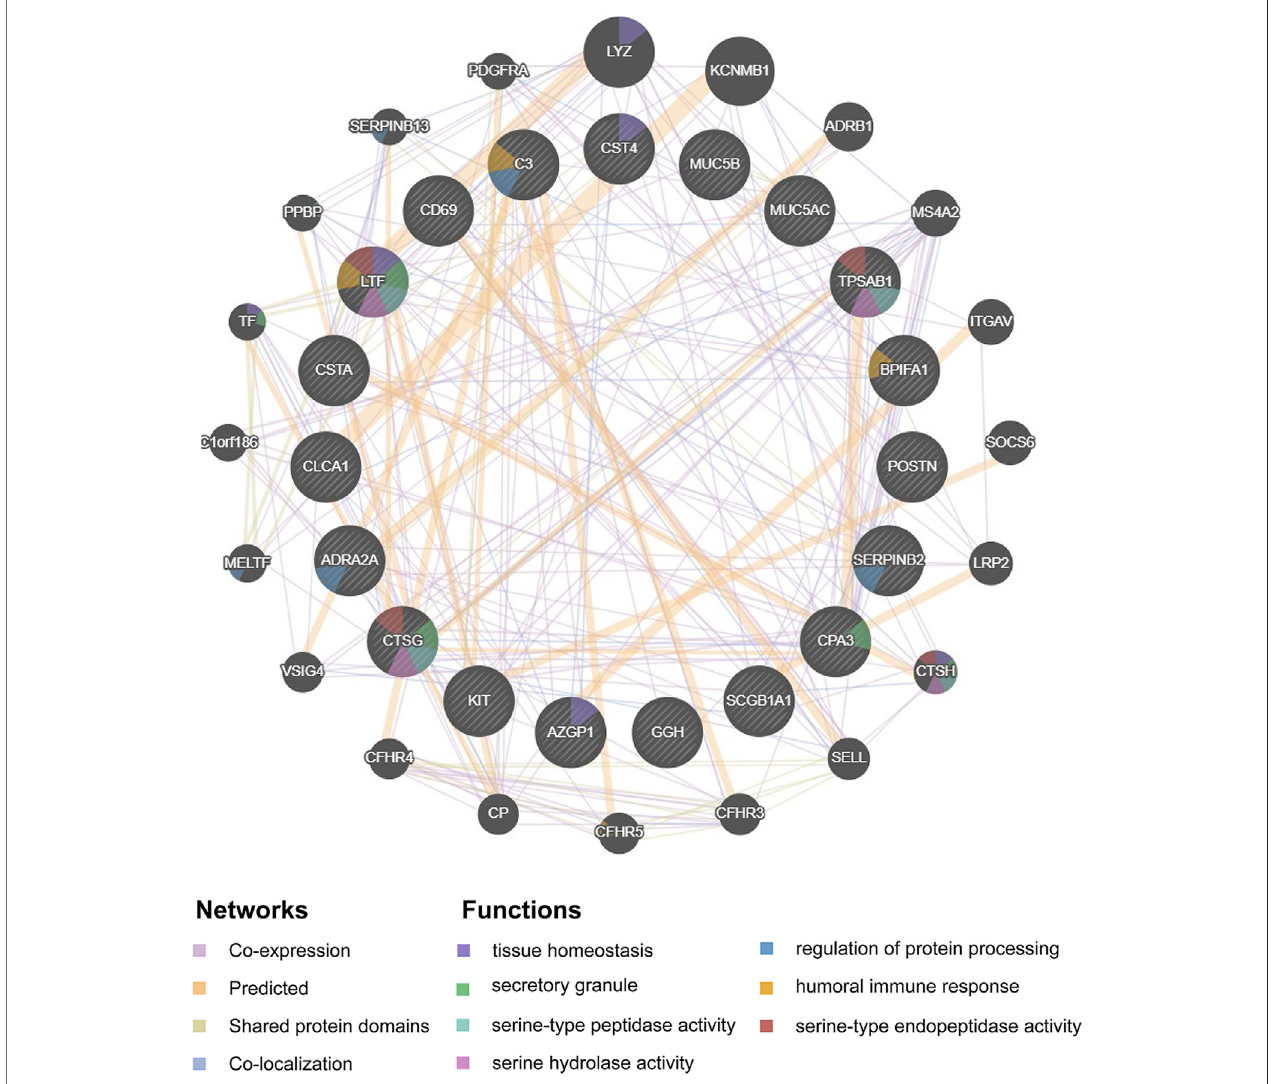
FIGURE 6 | Protein-protein interaction network of the 19 hub-genes target network. Protein-protein interaction network of the 19 hub-genes target network was constructed using GeneMANIA database. The colors of the edges in the network indicated different bioinformatics methods used, including co-expression, website prediction, shared protein domains, and co-localization. The colors of the nodes in the network indicated the functional enrichment analysis of the query gene list.